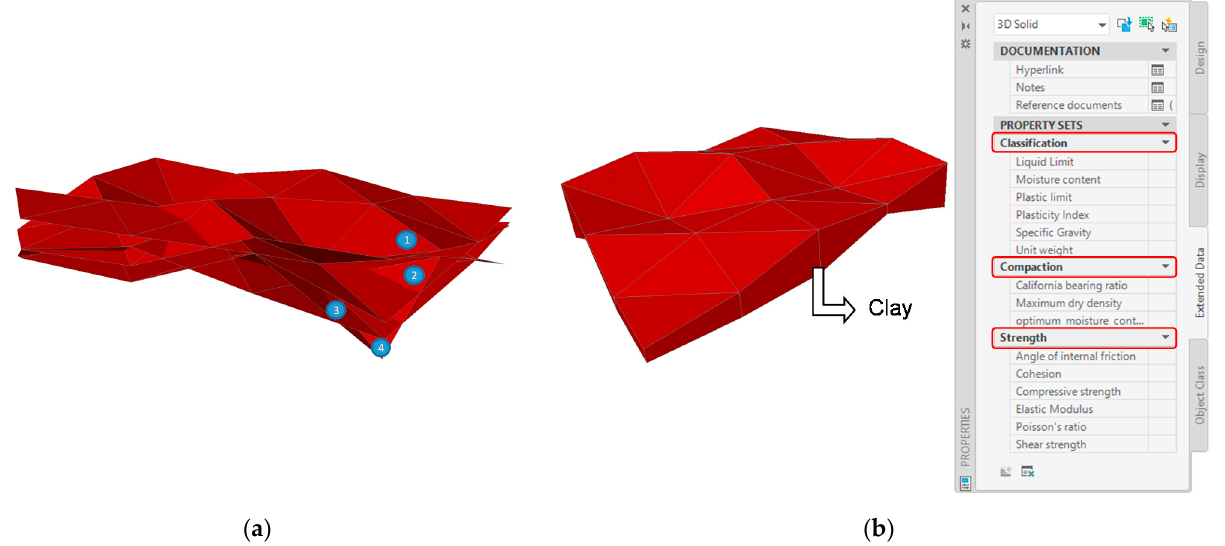
Figure 8. ( a ) Surface-based visualization of the available clay layers; ( b ) Solid-based representation of the available clay.